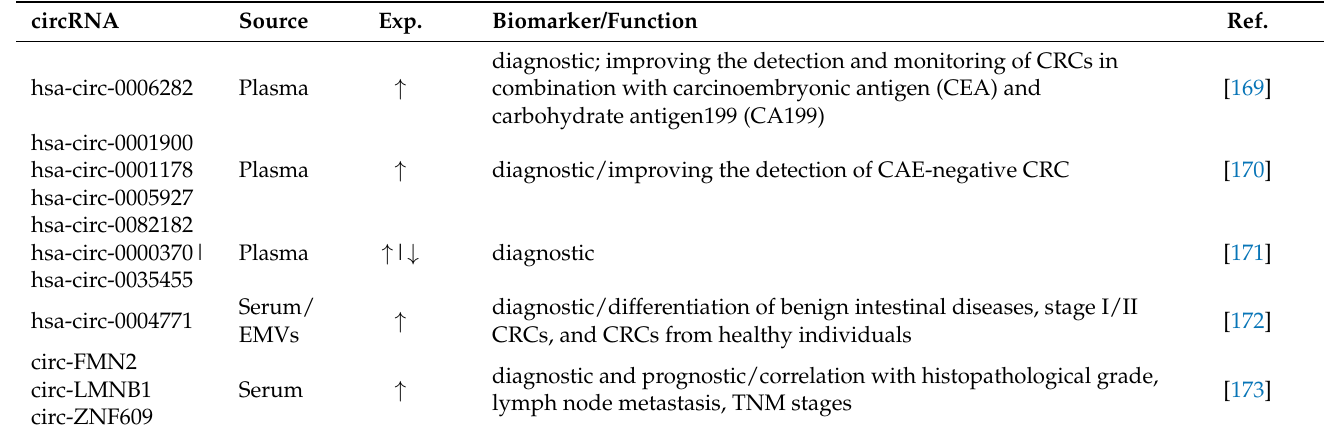
Table 8. List of circRNAs described as biomarkers for CRC diagnosis and screening (from liquid